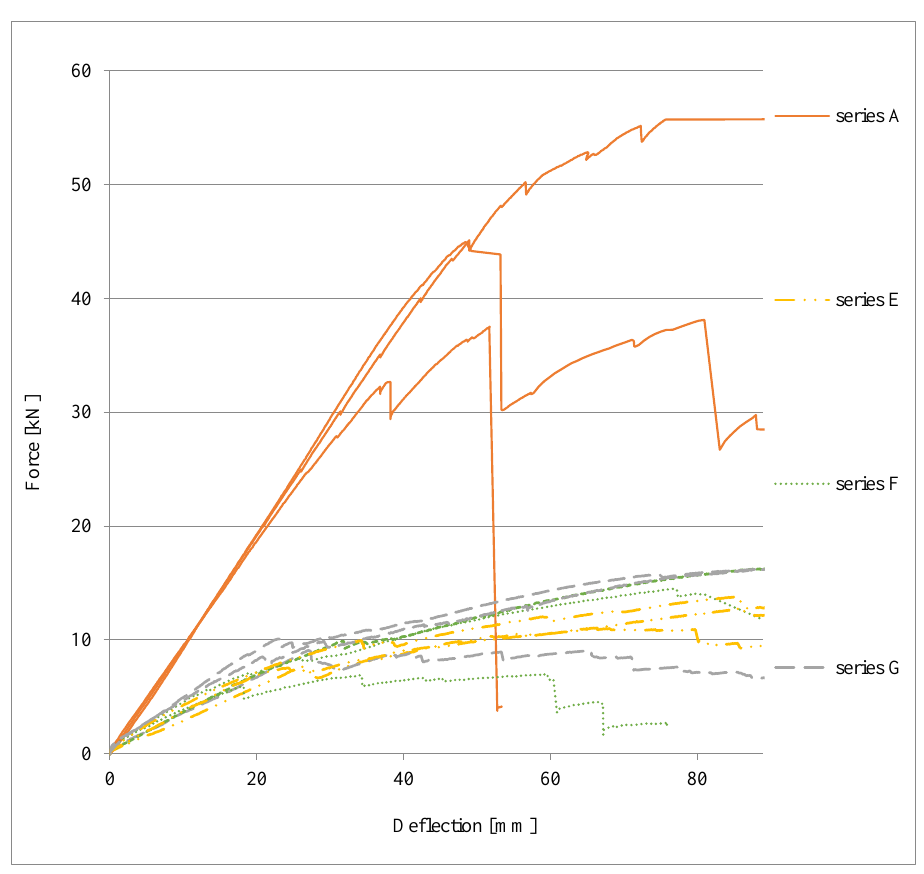
Figure 19. Comparison of load-deflection plots of beams of series E, F, G to the reference beam of series A.